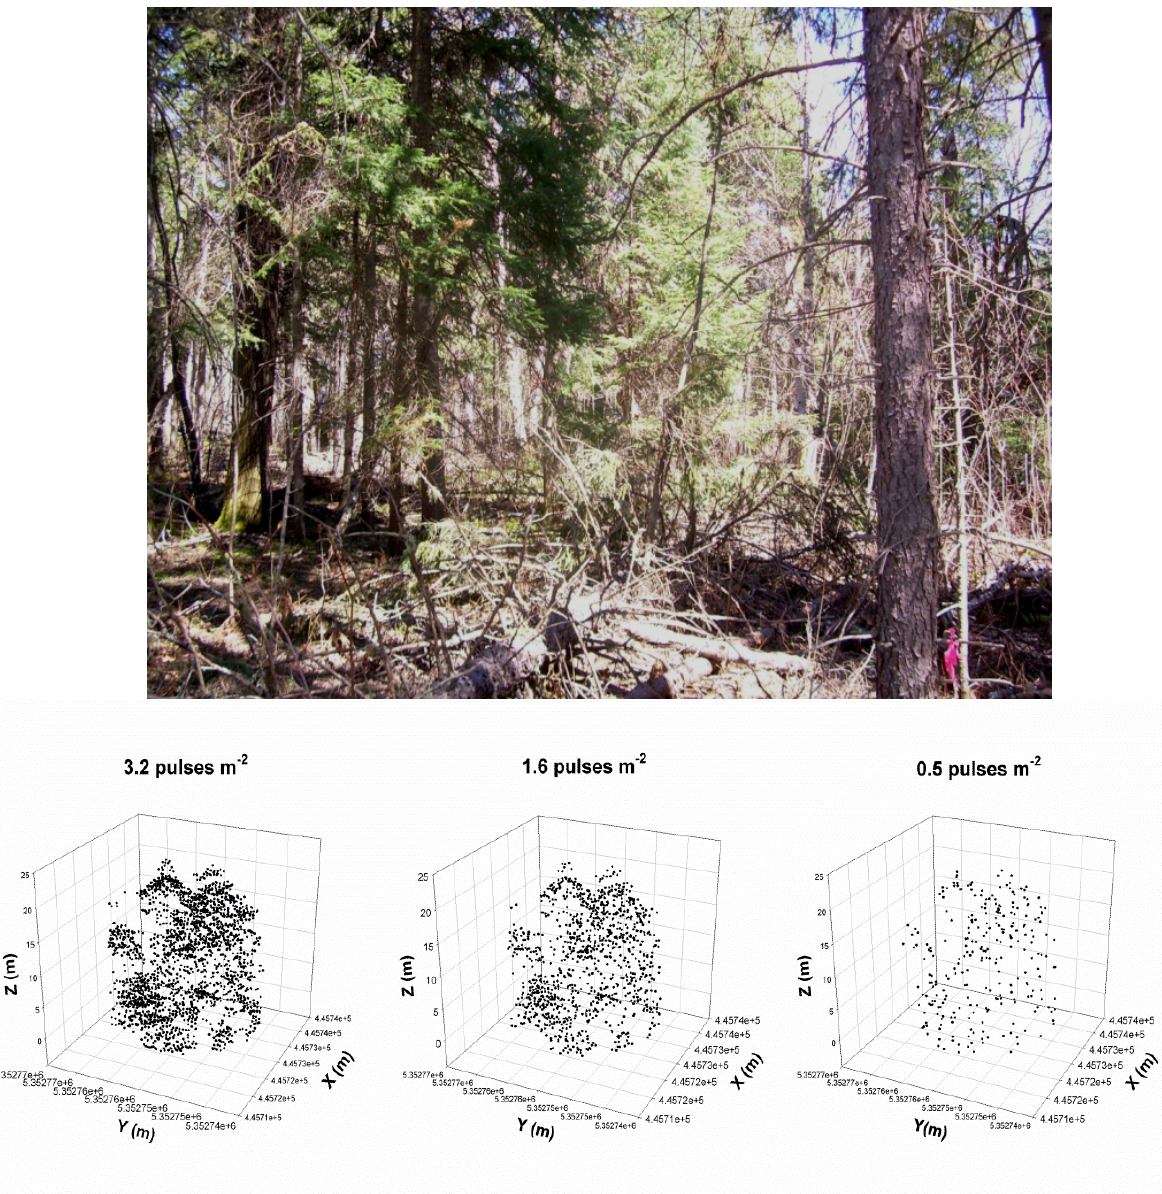
Figure 2. Lidar point clouds for a boreal mixed wood plot ( top ) at the three scanning densities: D0: 3.2 pulses m − 2 ( left ); D1: 1.6 pulses m − 2 ( middle ); and D2: 0.5 pulses m − 2 ( right